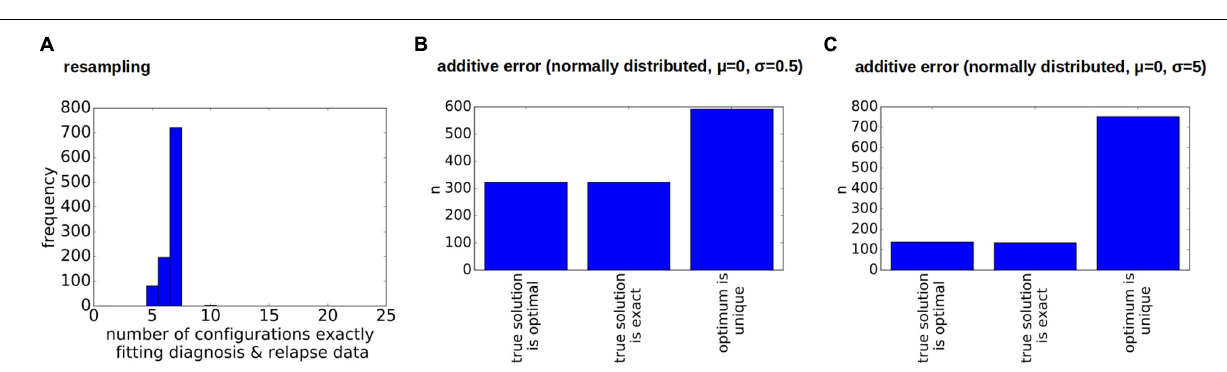
FIGURE 8 | Impact of errors on the reconstructions for a sample with two founders. (A) Impact of sampling error on the number of clonal hierarchies compatible with diagnosis and relapse data. The vertical axis shows how many of the 1,000 multinomial respamplings were compatible with 1, 2, 3, ... hierarchies respectively. (B,C) Impact of measurement errors on the reconstructed hierarchies. We considered 1,000 perturbed versions of the original data. Additive perturbations of the VAF were drawn from a normal distribution with mean zero and standard deviation 0.5% (B) or 5% (C) . We observe that in the majority of cases the true configuration is not